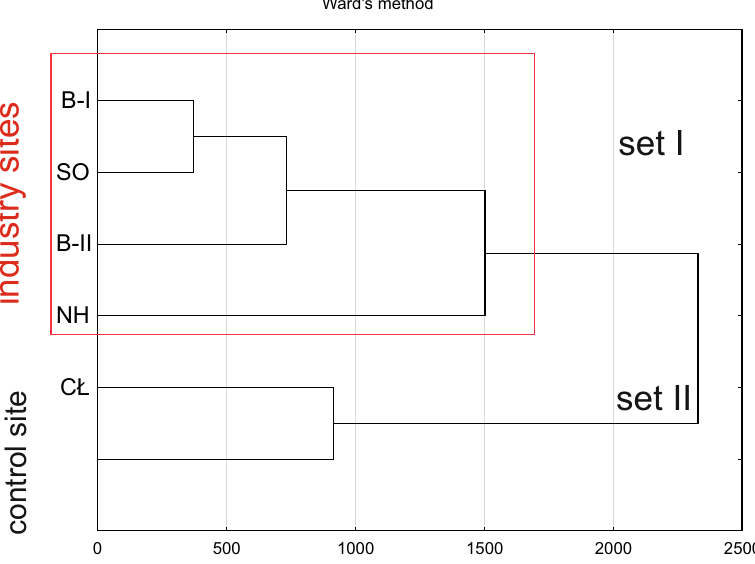
Figure 2. Cluster analysis carried out for the content of all macro- and microelements in lettuce.